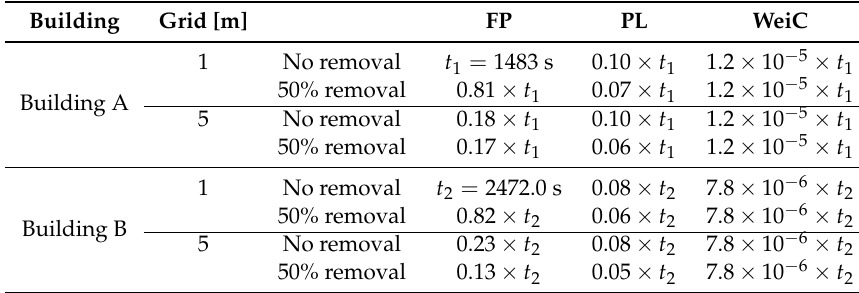
Table 3. Performance comparison via algorithm time consumption [s] for 250 user measurements. All positioning methods included with 1 m and 5 m grids, with no AP selection and 50% AP